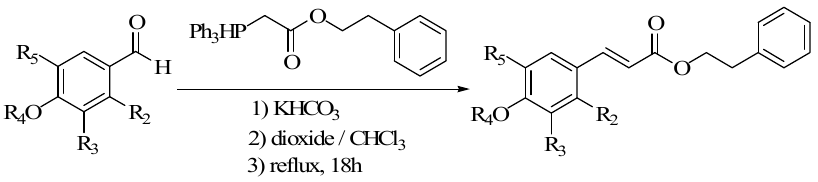
Figure 14. The scheme of fluorine substituted derivatives of CAPE.